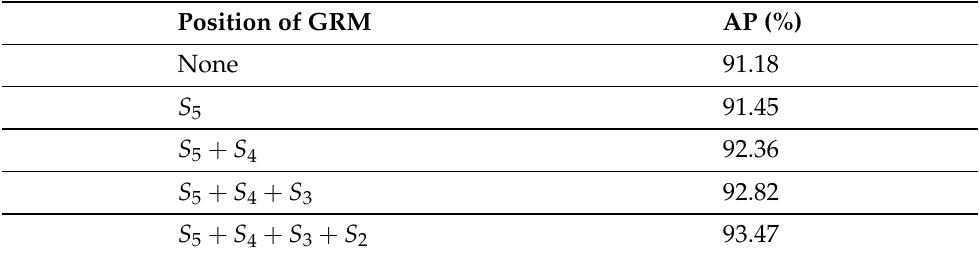
Table 2. The influence of the number of GRM blocks on the Brainwash test